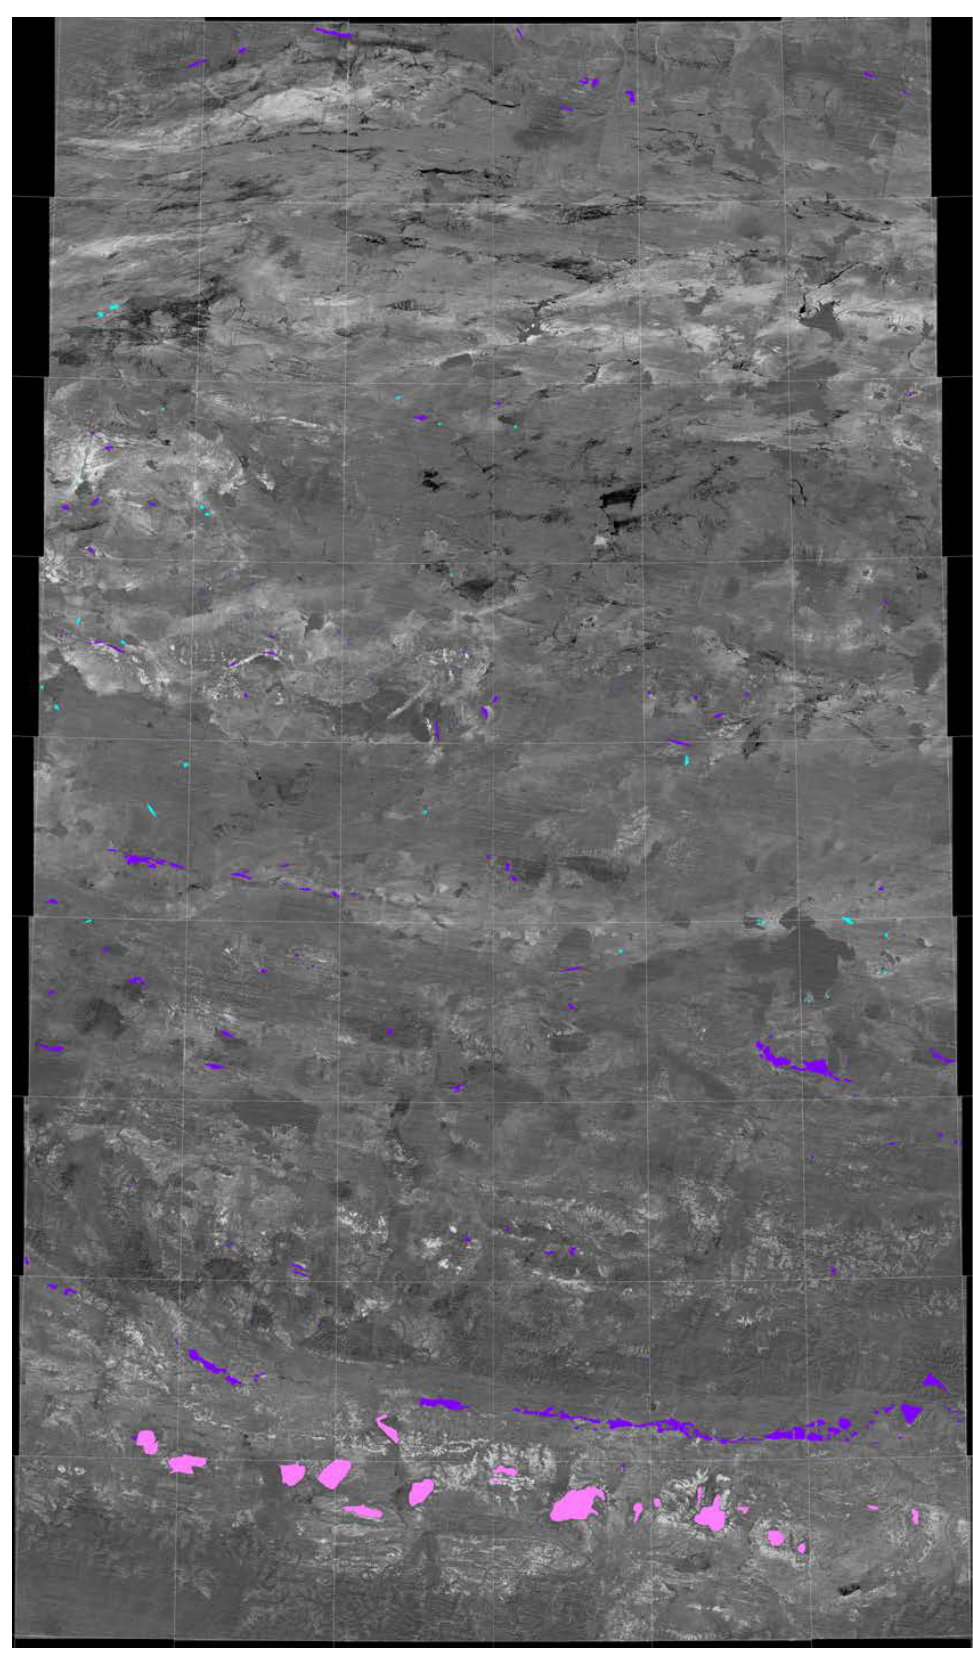
Figure A7. High resolution version of Figure 8 without annotated information.